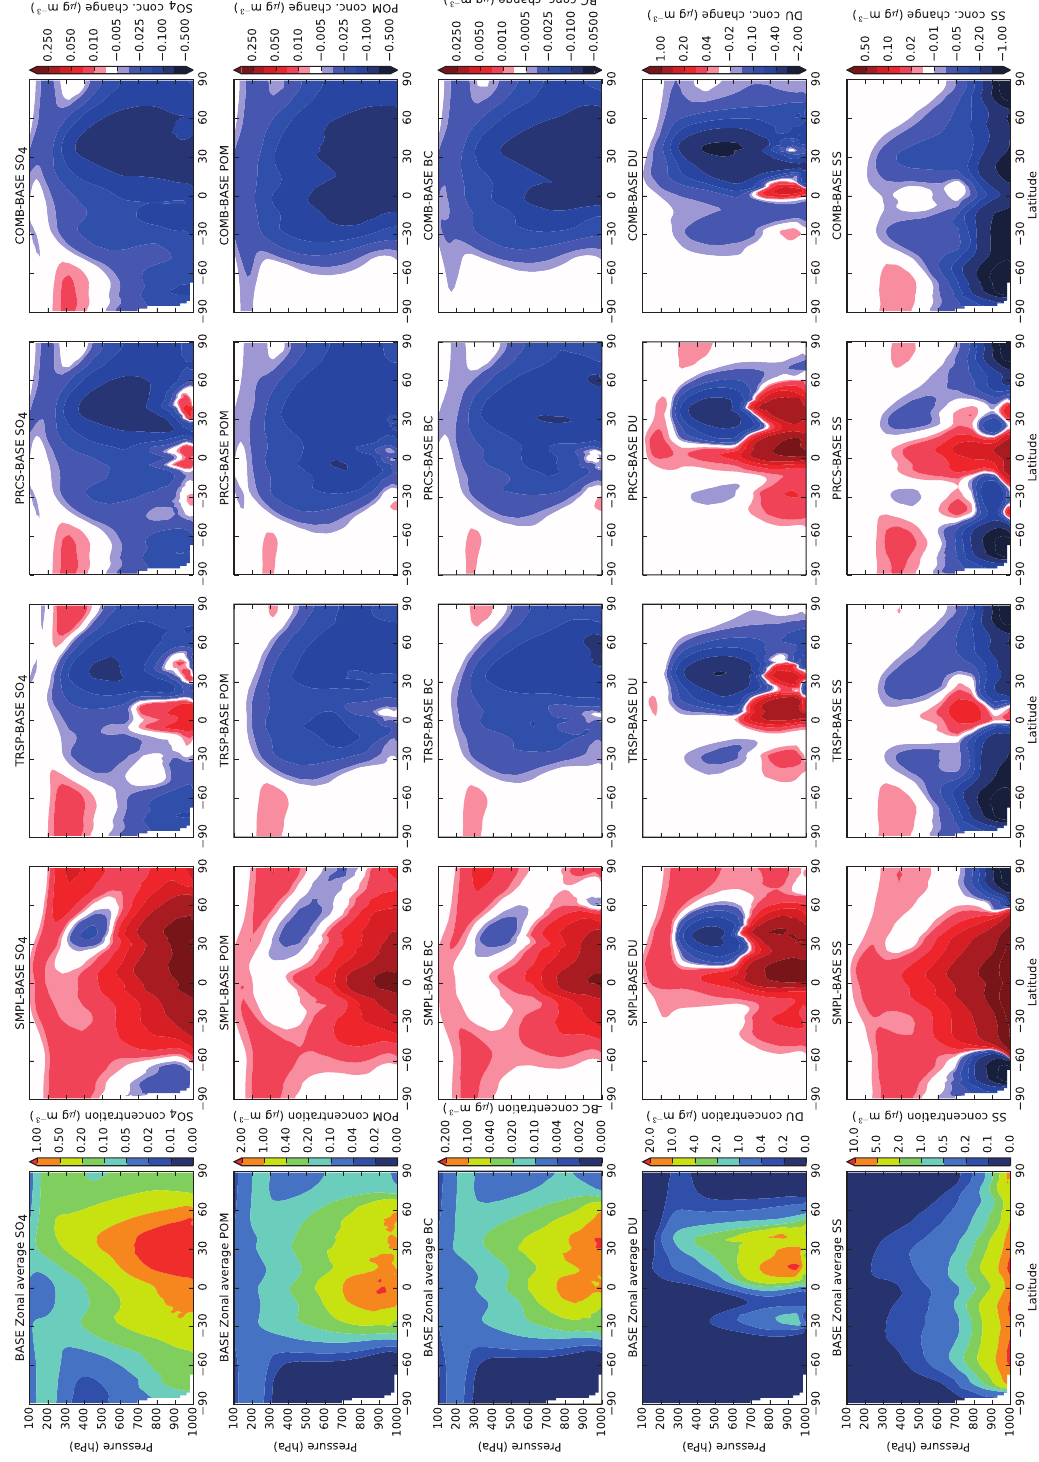
Figure 8. Annual average, zonal mean concentrations (µgm − 3 ) of M7 aerosol species in the BASE simulation and differences (µgm − 3 ) compared to the BASE simulations compared in the other simulations. Each row represents one of the aerosol species, from top to bottom: sulfate (SO 4 ), particulate organic matter (POM), black carbon (BC), mineral dust (DU) and sea salt (SS). Each column corresponds to a single simulation, from left to right: BASE, SMPL, TRSP, PRCS and COMB